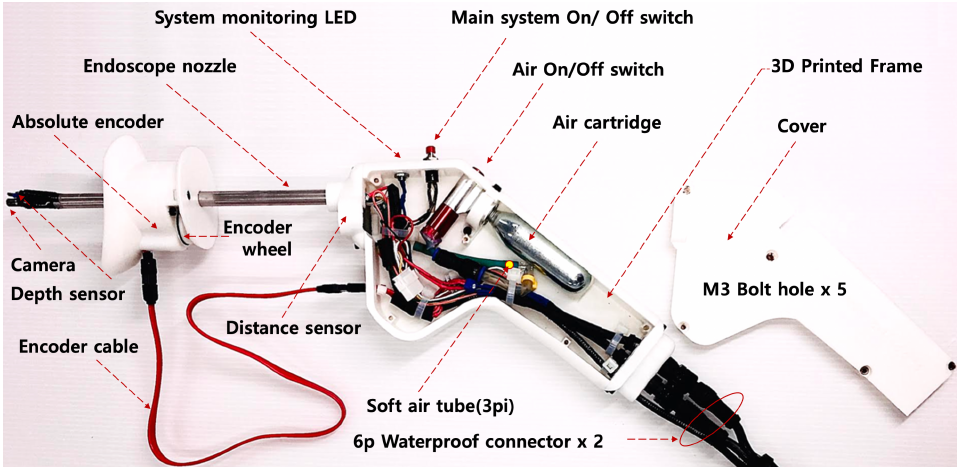
Figure 6. Mechanical design of endoscope based on three-dimensional printing